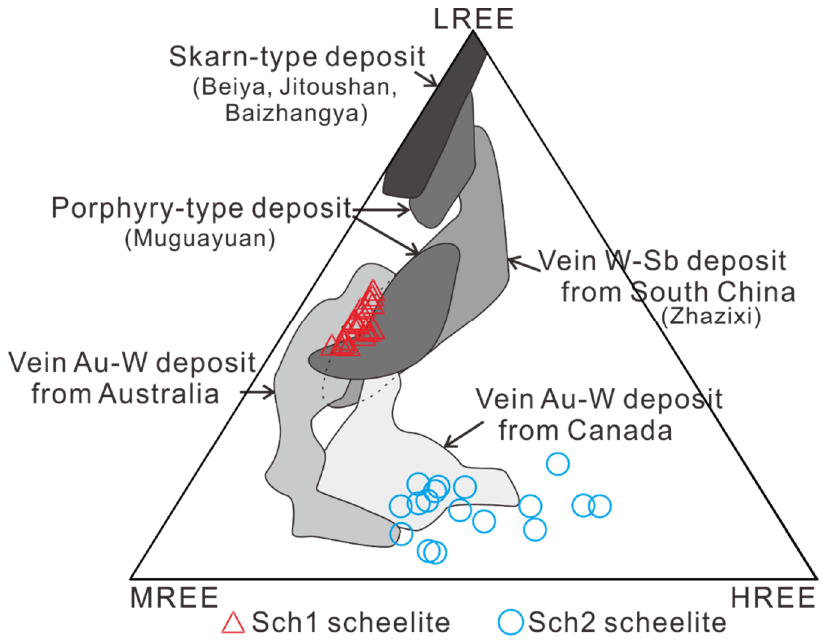
Figure 12. Triangular LREE-MREE-HREE diagram of the scheelite from the Longshan Sb-Au deposit. The REE data of other scheelite from skarn-type deposits, porphyry-type deposit, vein W-Sb deposit, and vein Au-W deposits are from Song et al. [15] and Fu et al. [61]; Li et al. [63]; Peng et al. [50]; Ghaderi et al. [1], Brugger et al. [16], and Dostal et al. [4].